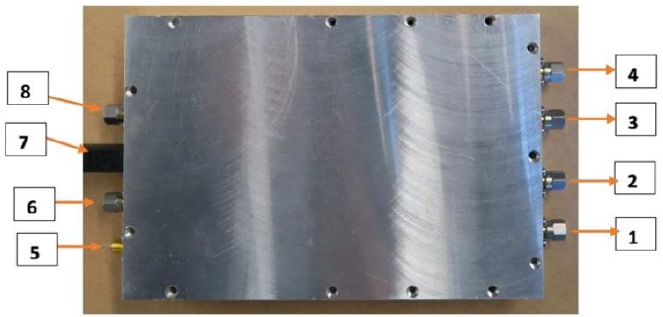
Figure 7. Photograph of the enclosed B210 with labels indicating probe measurement sites. Table 1. Measured leakage signal values at 900, 1300, and 1700 MHz for circuit board locations with: ( a ) no shield and ( b ) shielded housing, respectively, for Channel 1. Location of